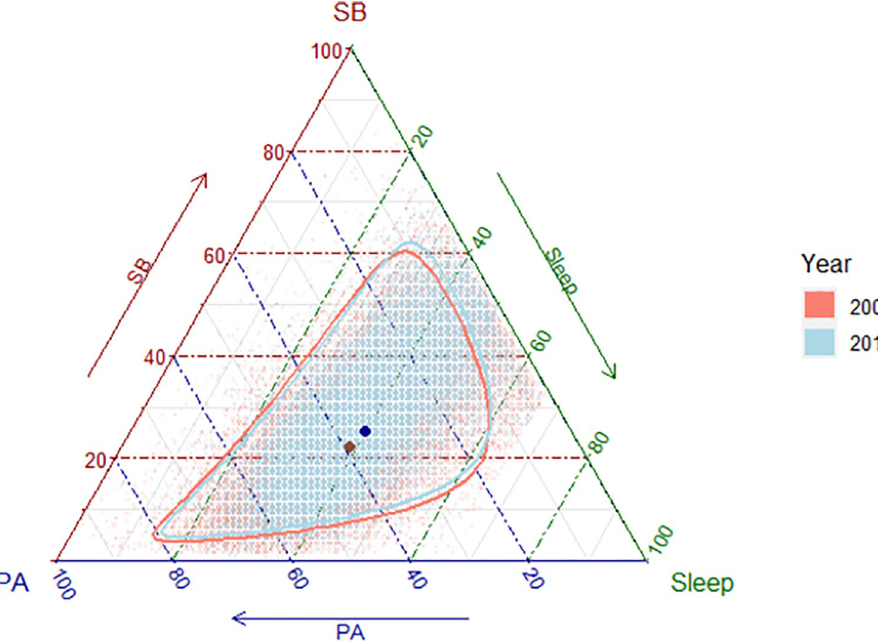
Fig 1. Compositional means of physical activity, sedentary behaviour, and sleep time in the Thai population in 2009 and 2015. The orange and blue circles on the graph represent the compositional means in 2009 and 2015, respectively. The orange and blue dots on the graph represent individual data points in 2009 and 2015, respectively. The orange and blue lines represent the 95% confidence boundaries for the compositional means in 2009 and in 2015, respectively. PA = physical activity; SB = sedentary